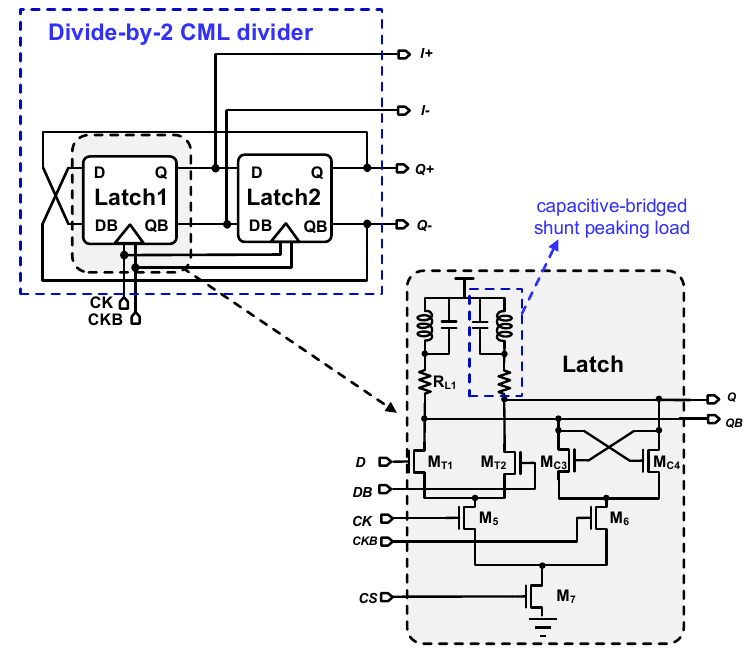
Figure 9. Proposed CML static frequency divider structure.